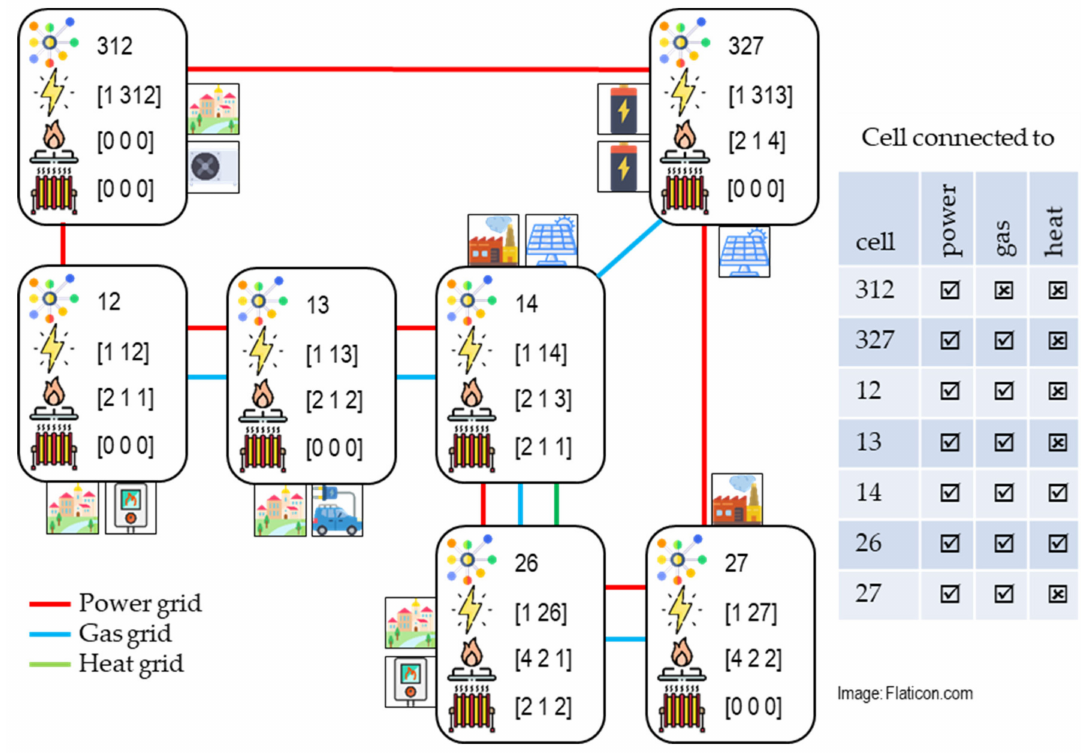
Figure 3. Energy infrastructure depiction.